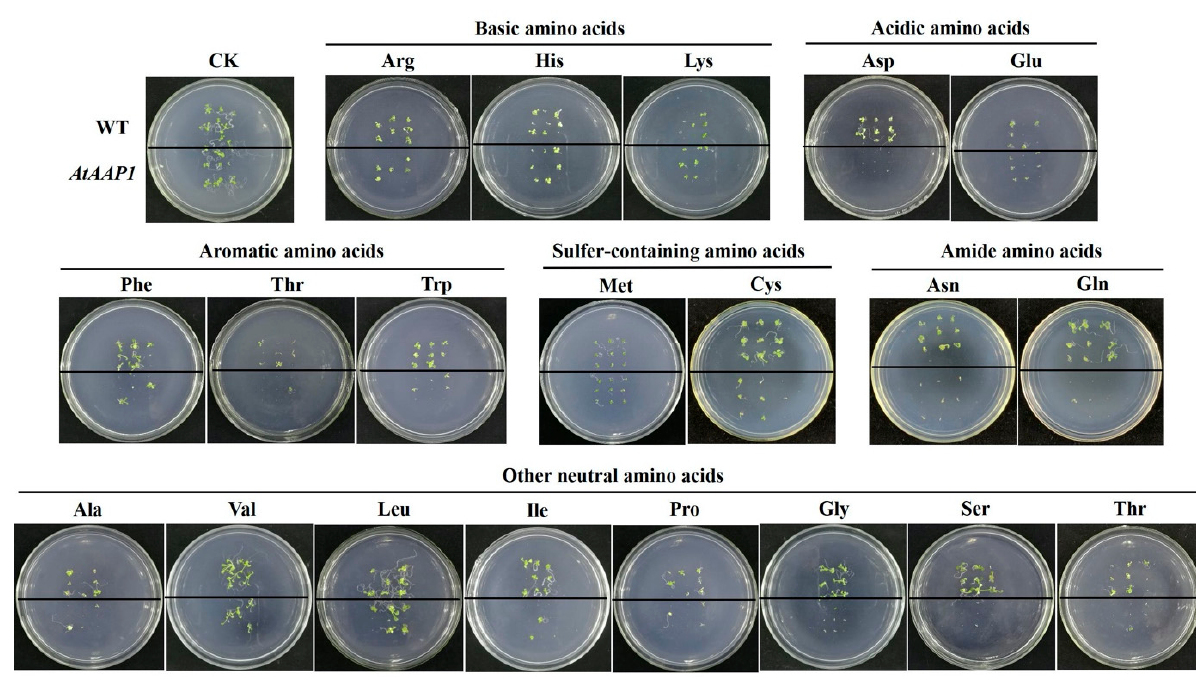
Figure 7. Affinity of 20 amino acids in wild-type (WT) and transgenic plants of Arabidopsis thaliana with overexpression of AtAAP1 . CK is the control MS medium without any amino acid in the medium.